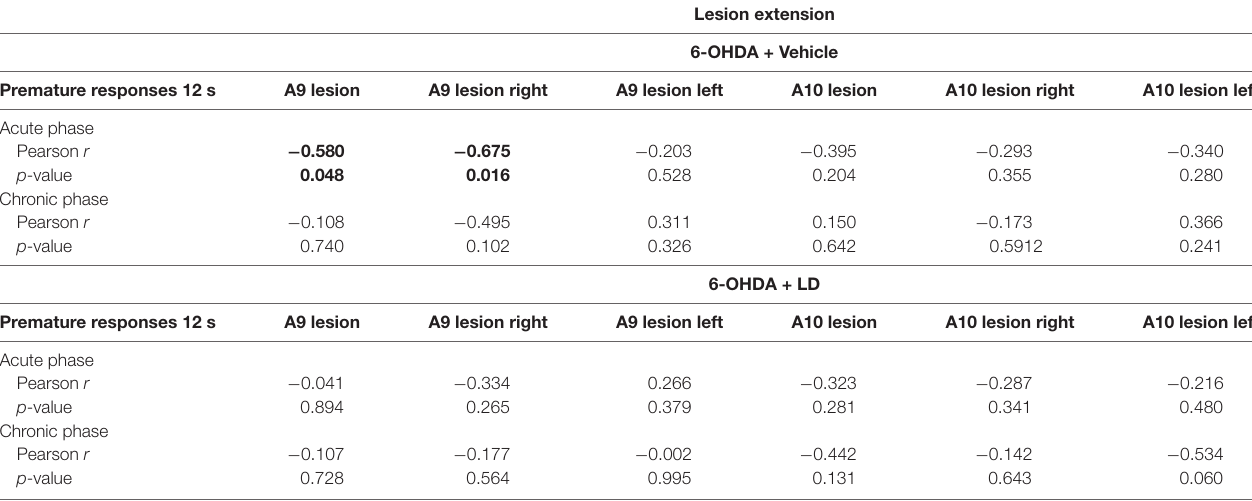
TABLE 1 | Correlation analysis between A9/A10 lesion extent and premature responses during the 12 s delay trials of the variable delay-to-signal (VDS).